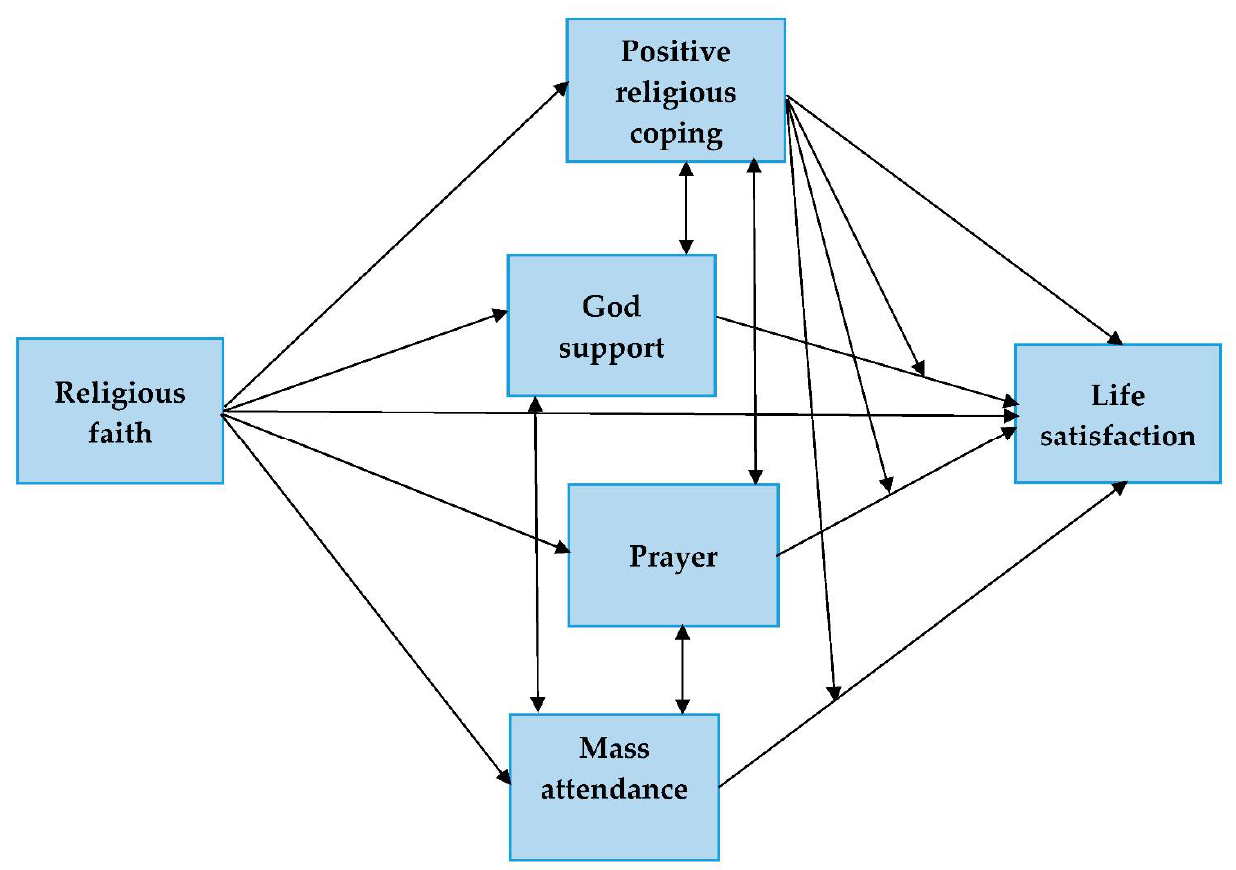
Figure 1. Model of research.